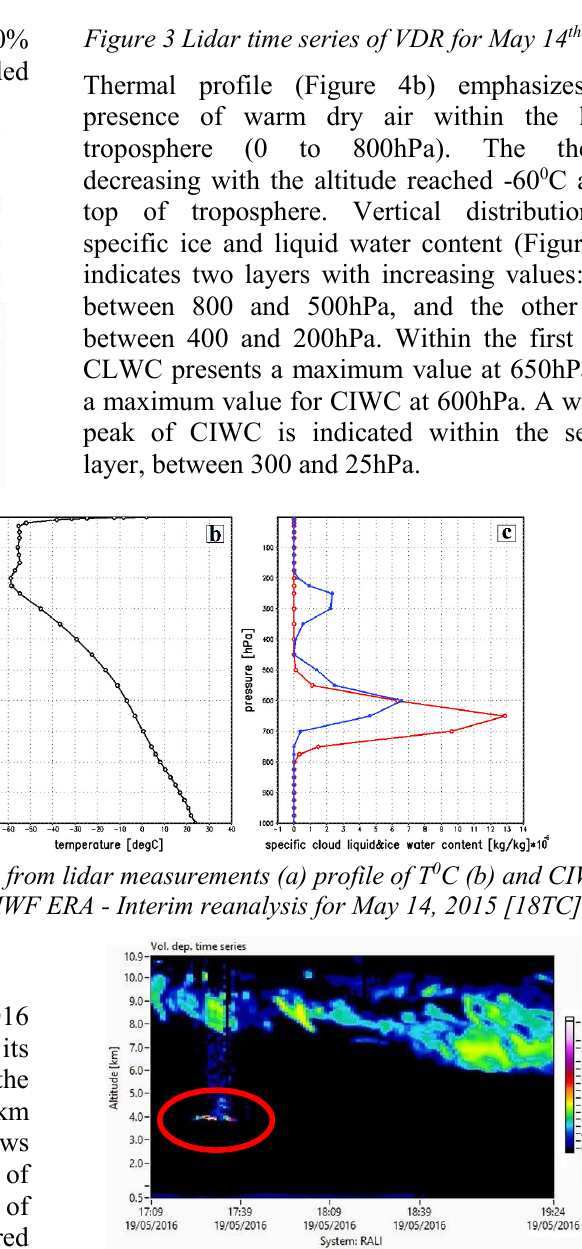
Figure 2 Time series of ice to liquid water ratio from lidar measurements (a), profile of T 0 C (b) and CIWC (blue line) & CLWC (red line) (c) from ECMWF ERA - Interim reanalysis for May 16, 2014 [12TC]